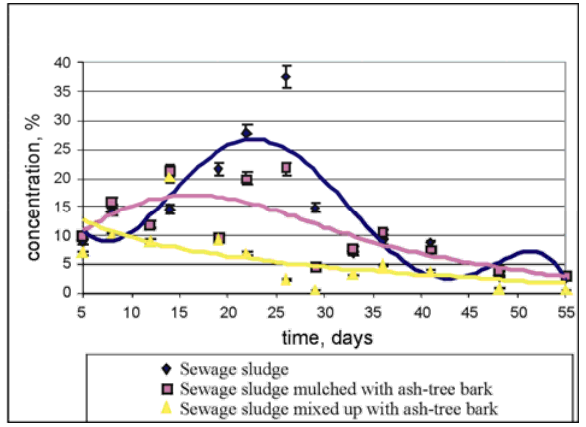
Fig. 9. Methane gas emissions during composting sewage sludge with oak sawdust